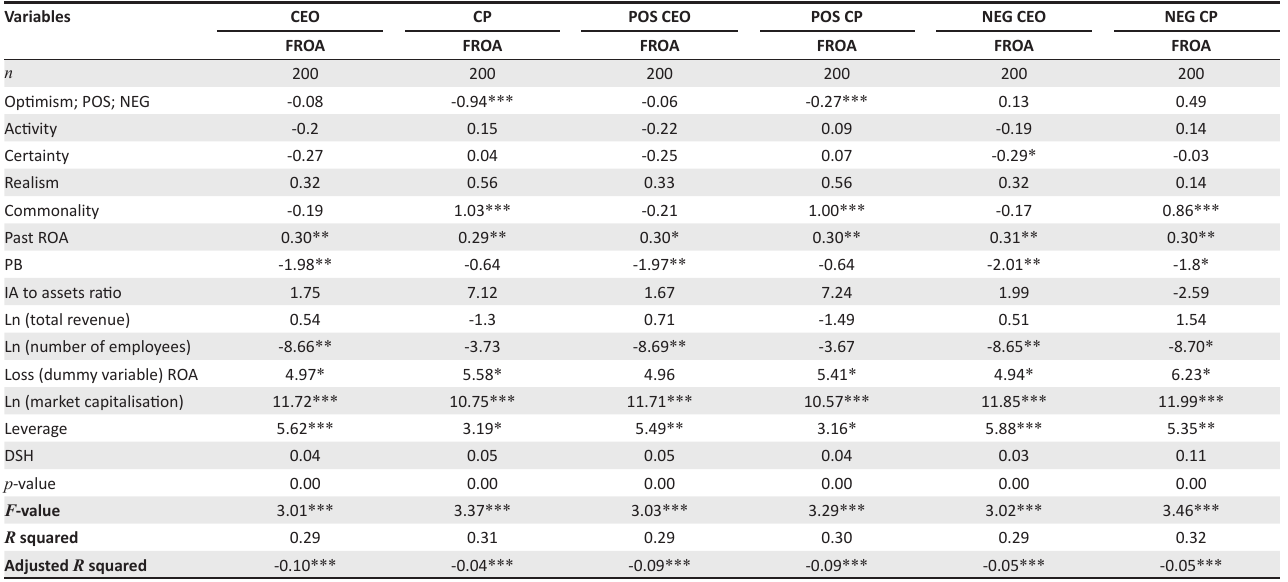
TABLE 2: Regression results of optimism on future performance.